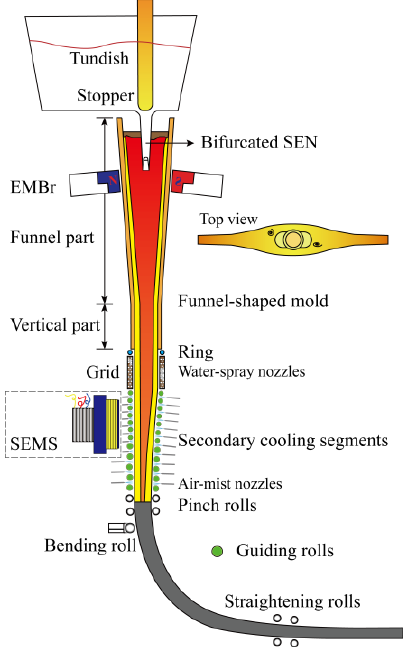
Figure 1. Overall schematic diagram of the compact strip production (CSP). The top edge of the electromagnetic brake (EMBr) magnet was immediately below the bottom end of the submerged entry nozzle (SEN). The strand electromagnetic stirring (SEMS) system was placed at the fixed side.